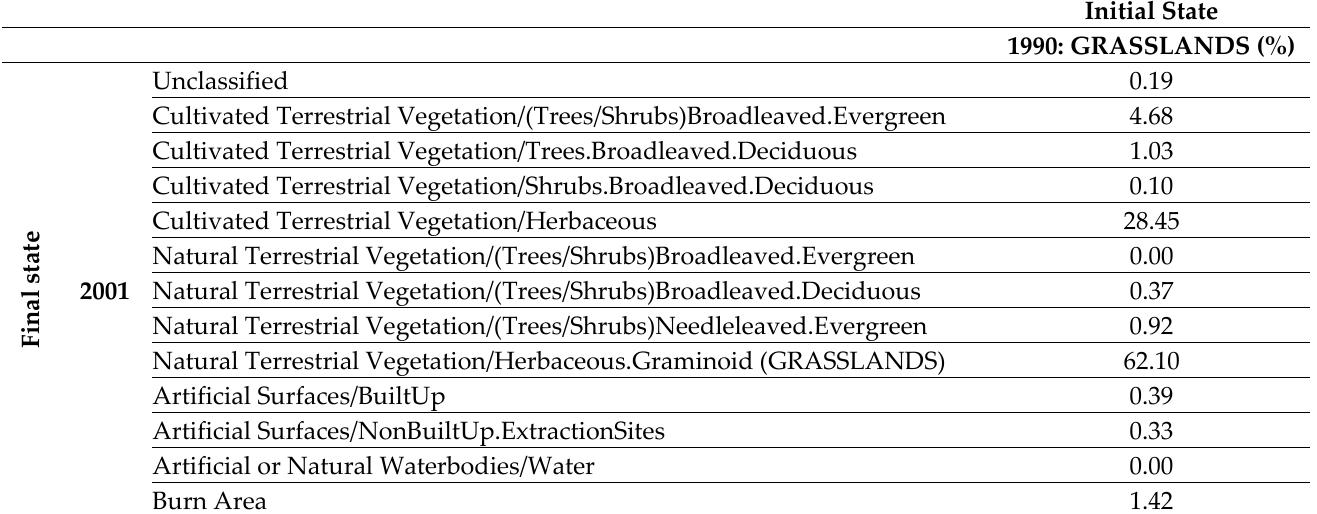
Table 6. Change matrix for grasslands transitions between 1990 and 2001 expressed as percentage of change respect to the initial state.